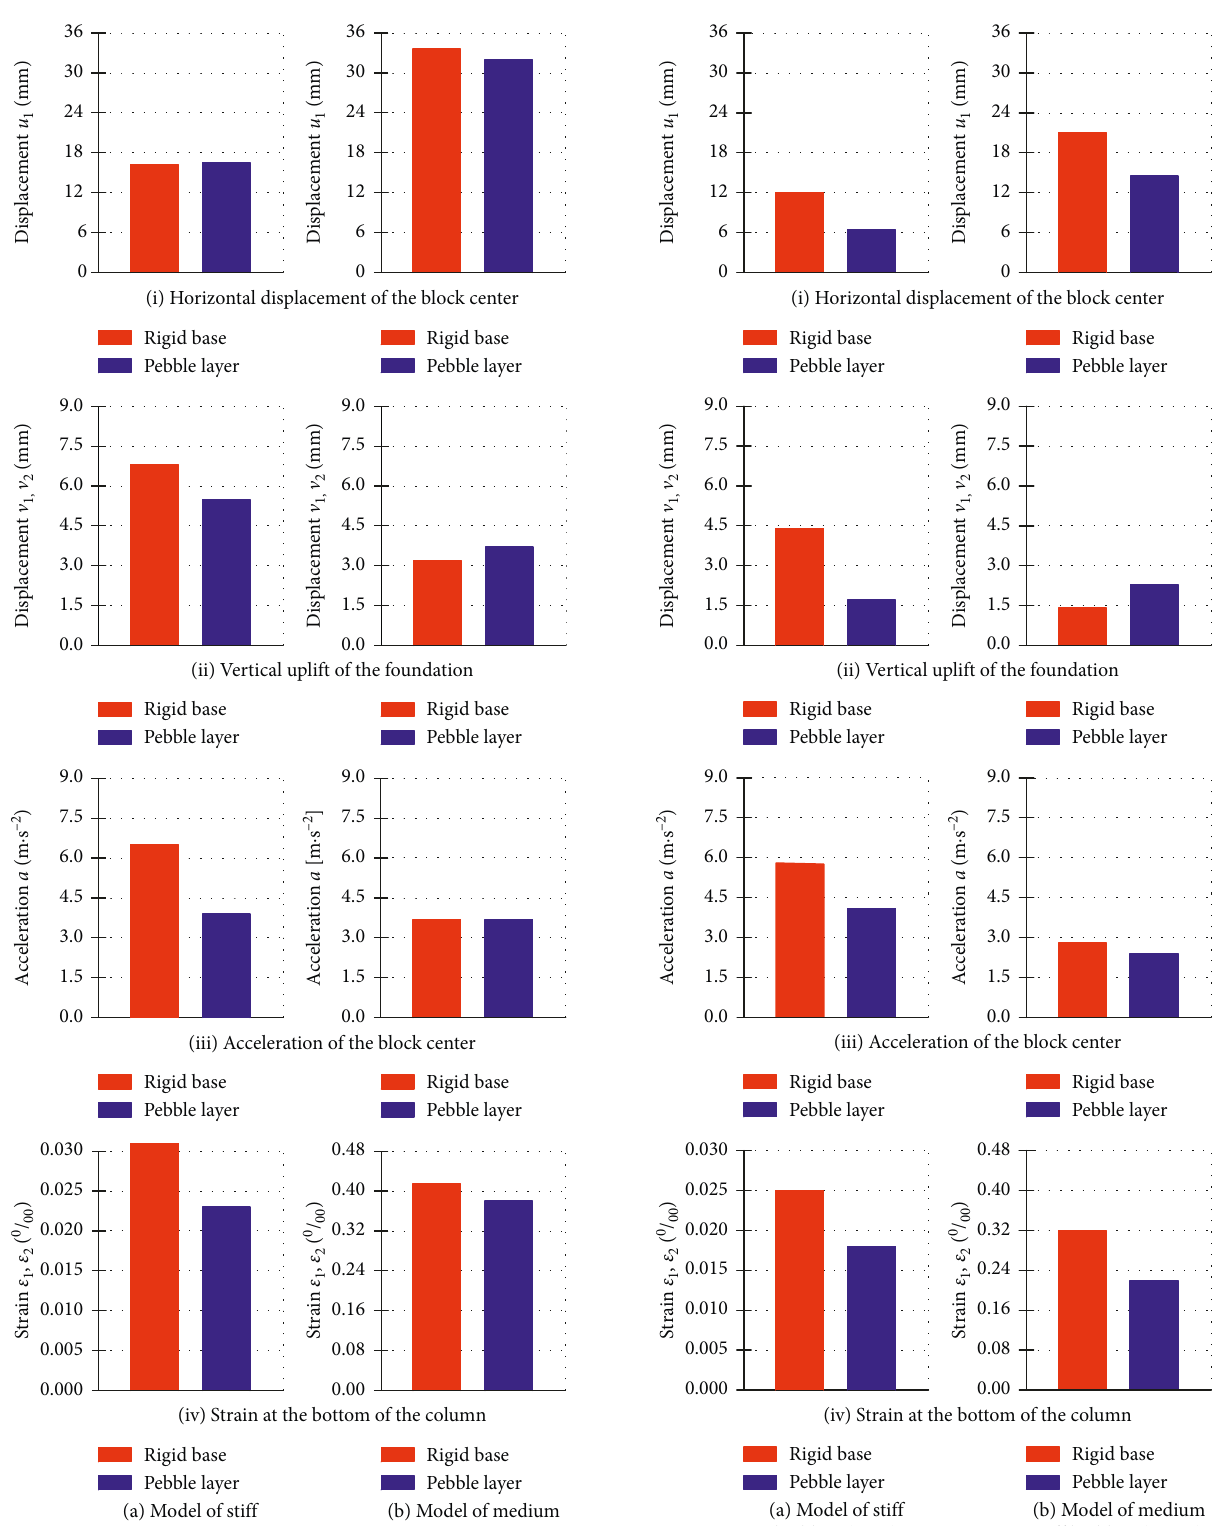
Figure 23: Some maximum measured values for the accelerogram B. Luka (ABL). (a) Model of stiff building (MSB). (b) Model of medium stiff building